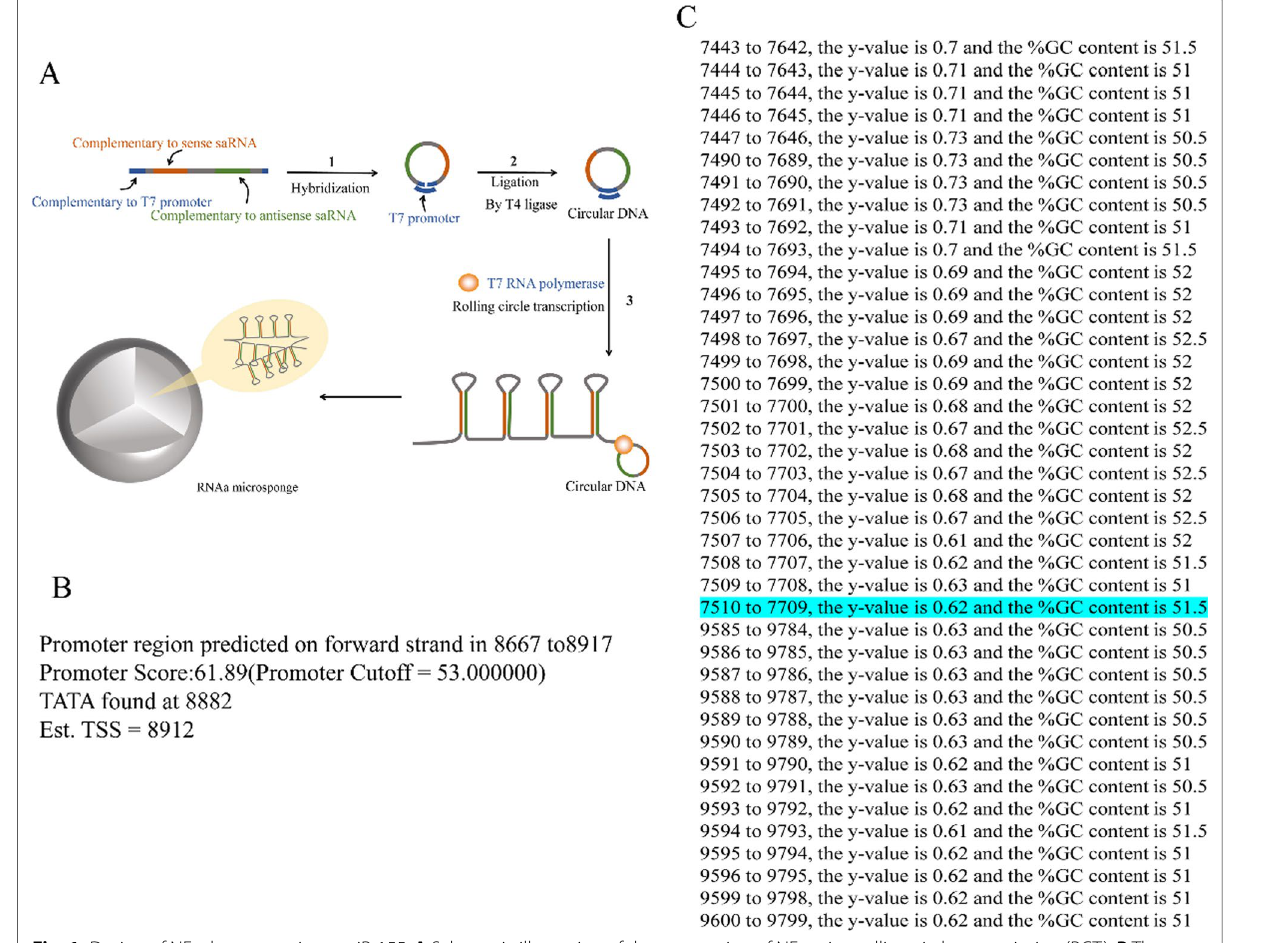
Fig. 1 Design of NFs that can activate miR-155. A Schematic illustration of the preparation of NFs using rolling circle transcription (RCT). B The transcription start site of 10,000 bases upstream from the 5 ′ end of the first exon of MiR155HG. C The enriched region of CpG islands